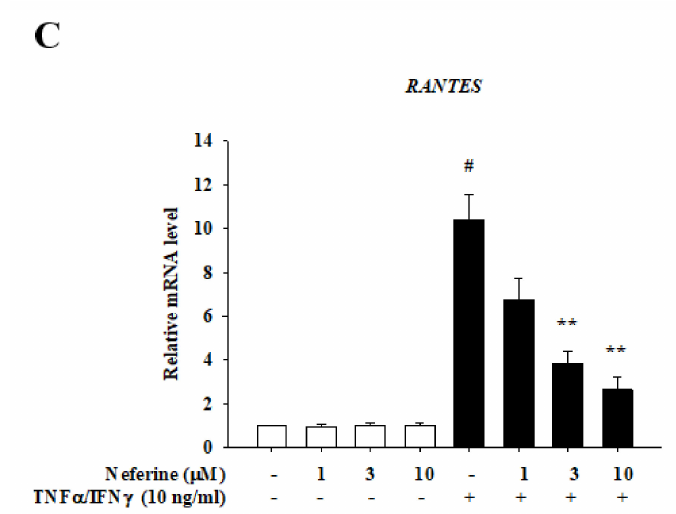
Figure 3. The effect of neferine on the mRNA expression levels of chemokines in TNF- α /IFN- γ -stimulated HaCaT cells. HaCaT cells were pretreated with different concentrations of neferine (1, 3, and 10 µ M) for 20 min, and then the cells were treated with TNF- α /IFN- γ (10 ng/mL) for 24 h. The mRNA expression level of ( A ) TARC (CCL17), ( B ) MDC (CCL22), and ( C ) RANTES was determined using qPCR. Values represent the mean ± SEM from three independent experiments. # p < 0.05, ## p < 0.01 compared with the no-treatment condition; * p < 0.05 and ** p < 0.01 compared with the TNF- α /IFN- γ treatment condition.